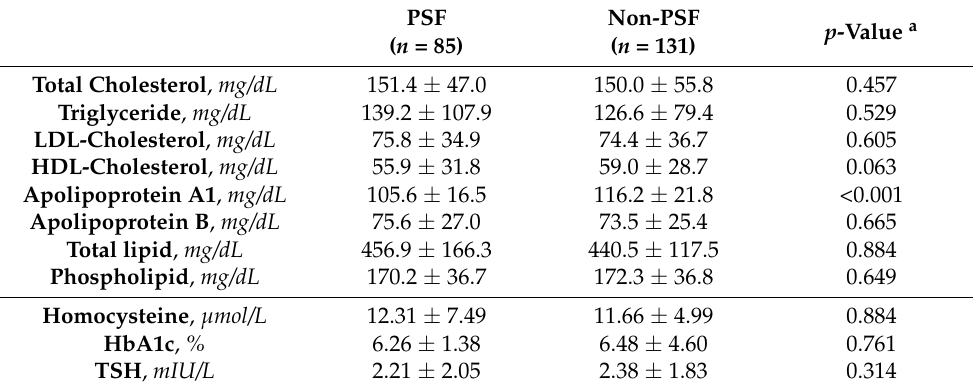
Table 5. Comparison of blood lipid data and endocrinologic laboratory data between the PSF and non-PSF